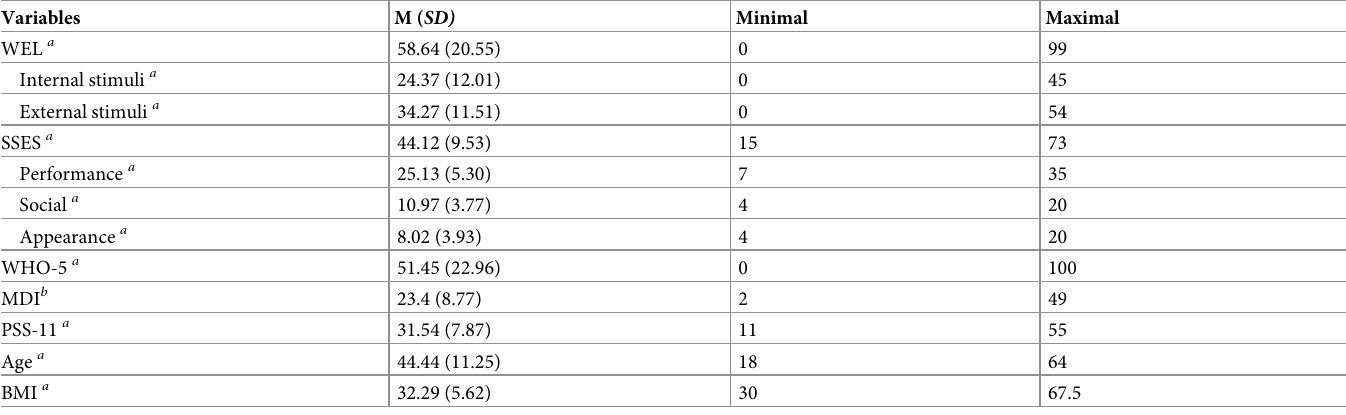
Table 6. Means and standard deviations of the assessment scales used in a French clinical sample.